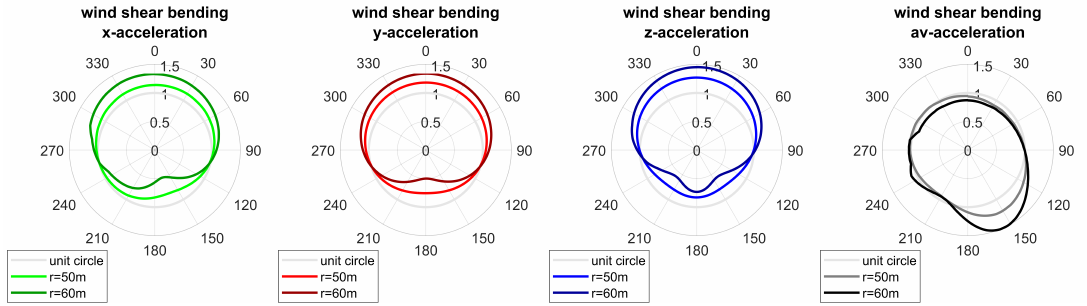
Figure 14. Bending shapes for sensors mounted at R = 50m, R = 60m, and β = γ =